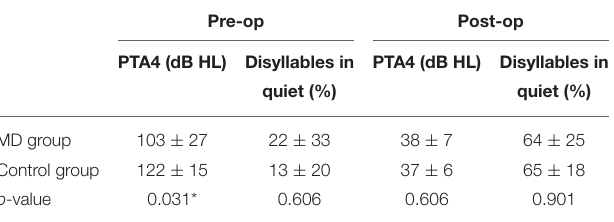
TABLE 2 | Audiometric